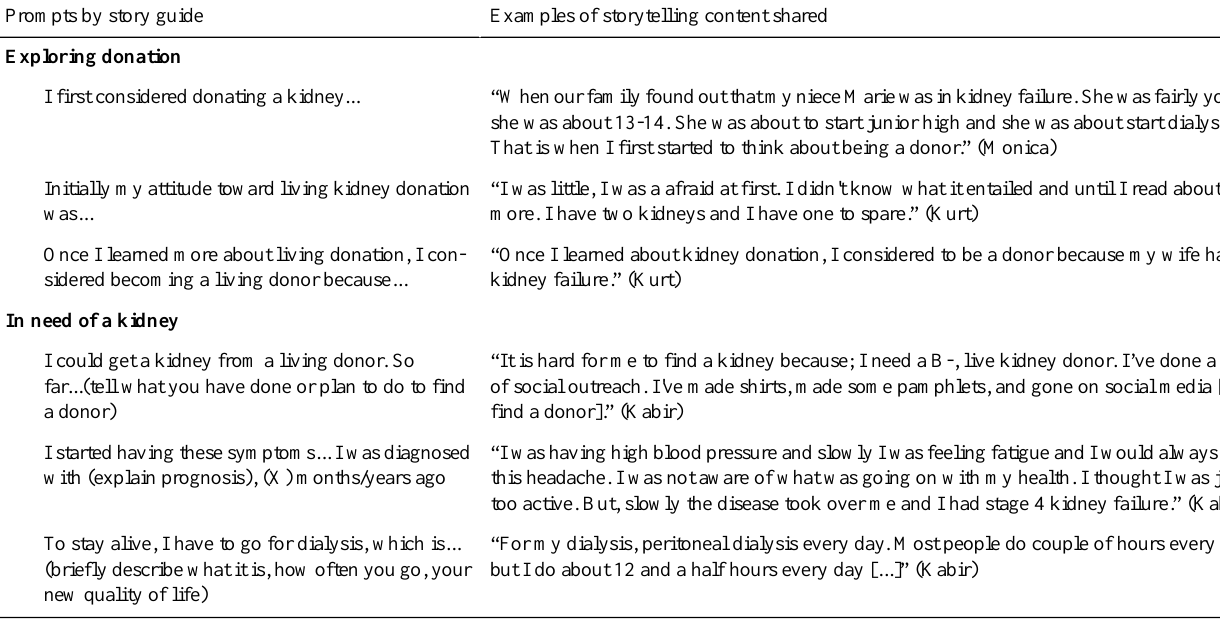
Table 4. Content shared by potential donors and kidney patients around open-ended prompts.